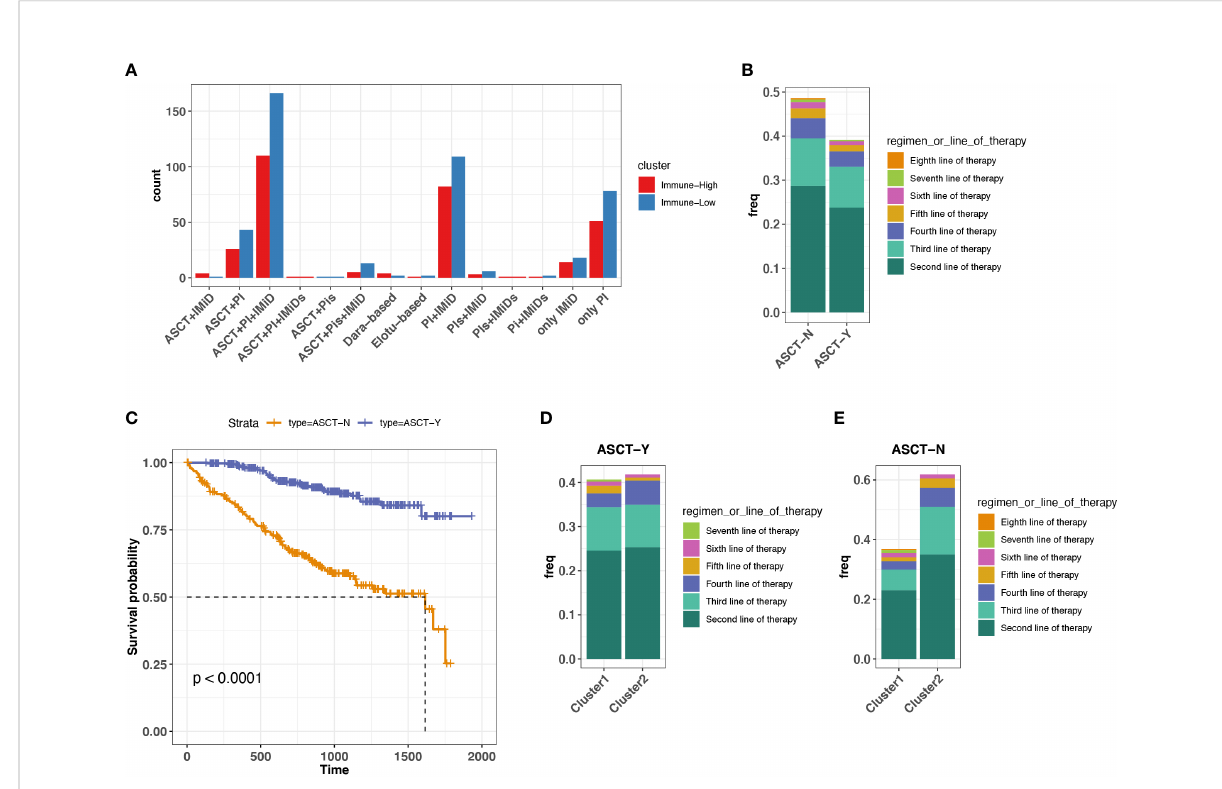
FIGURE 4 Association between treatment selection immune microenvironment in ND MM tumors. (A) Patient count with different drug combos in immune-low (cluster 1) and immune-high (cluster 2) tumors. (B) Frequency receiving treatments after the fi rst-line therapy for the patients with or without prior ASCT treatment. Colors indicate different line therapies. (C) Kaplan – Meier survival curve for ASCT treatment. (D) Comparison of frequency receiving treatments after the fi rst-line therapy between immune-low (cluster 1) and immune-high (cluster2) MM tumors with ASCT. Colors indicate different line therapies. (E) Comparison of frequency receiving treatments after the fi rst-line therapy between immune-low (cluster 1) and immune-high (cluster2) MM tumors without ASCT. Colors indicate different line